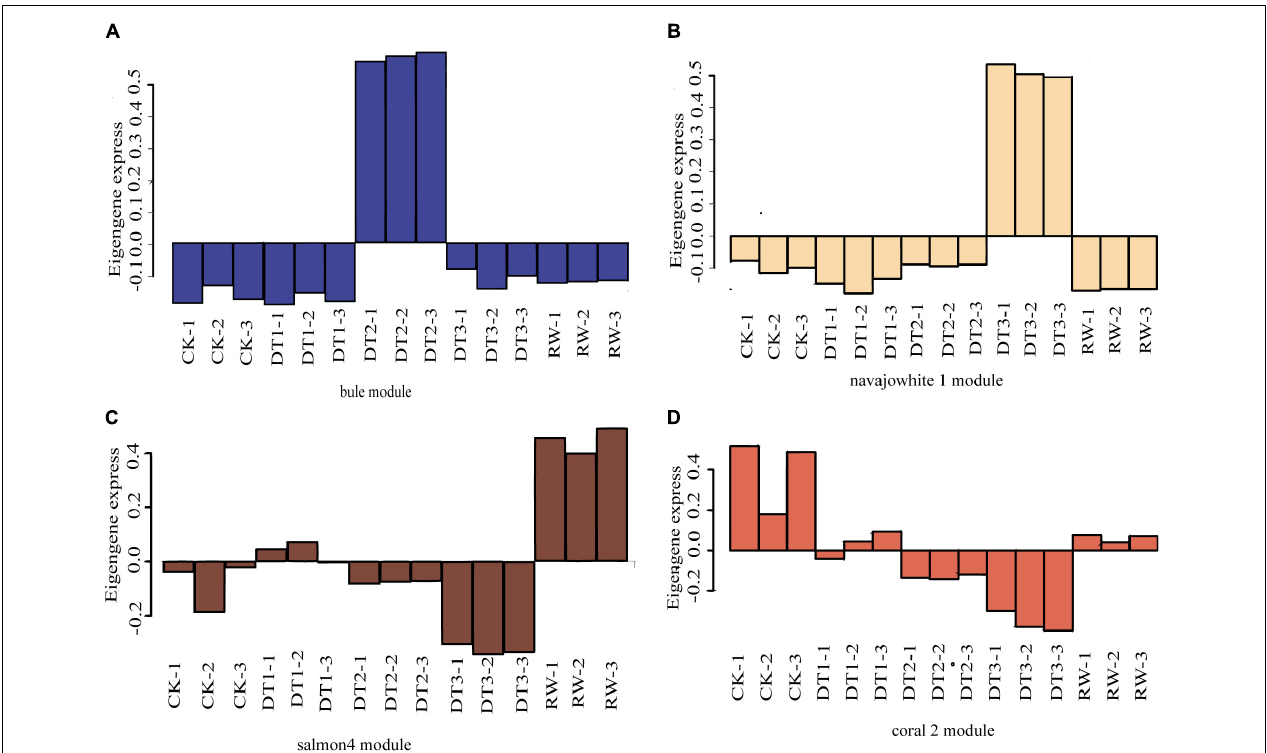
FIGURE 6 | The expression pattern of the co-expressed genes in the representative module. (A) Blue module. (B) Navajowhite1 module. (C) Salmon4 module. (D) Coral2